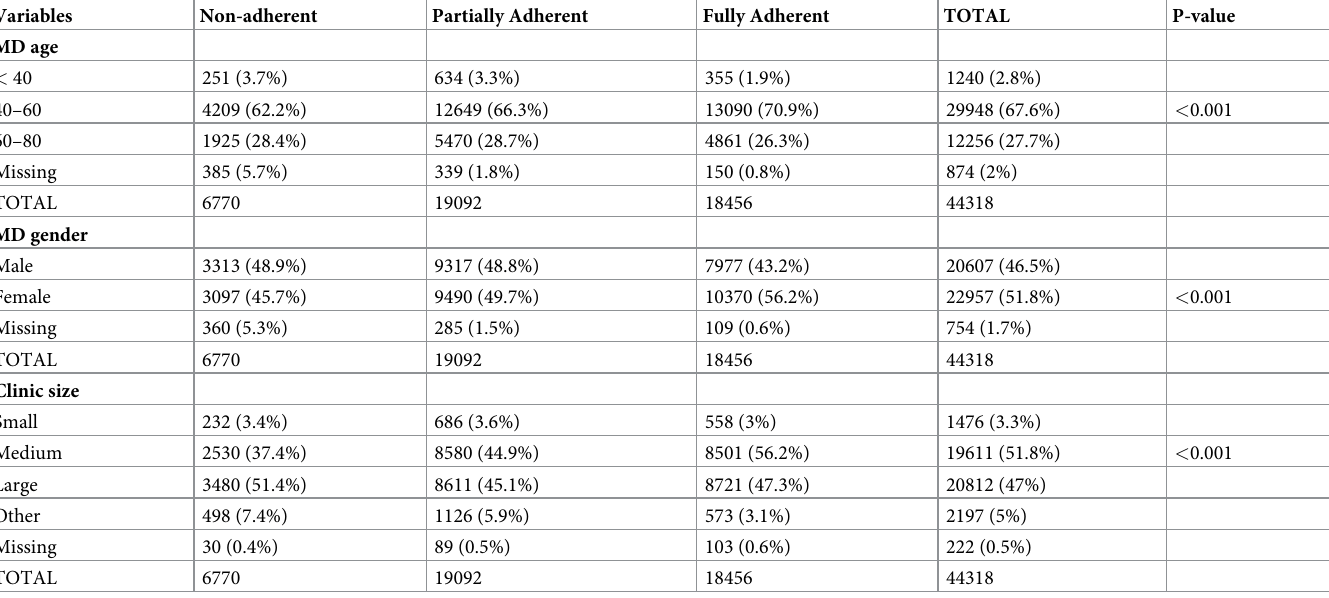
Table 2. Distribution of physician and clinic characteristics by adherence to mammography.